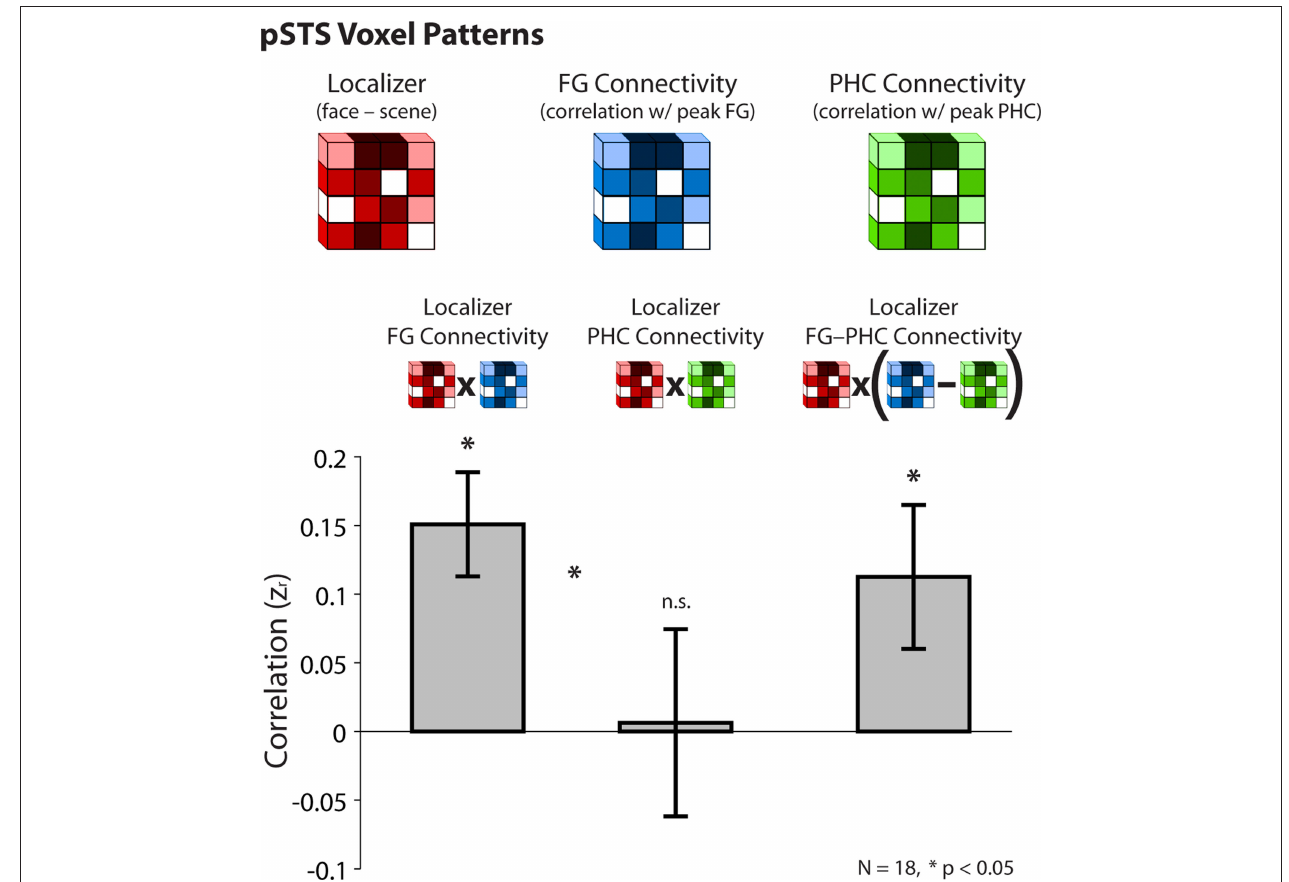
there was no such relationship in either direction for the PHC. Moreover, face-selectivity in the localizer (face–scene) predicted face-selectivity in partial resting connectivity (FG–PHC connectivity). Correlations were computed within-subject and converted to z -scores for statistical tests. Error bars reflect standard errors of the